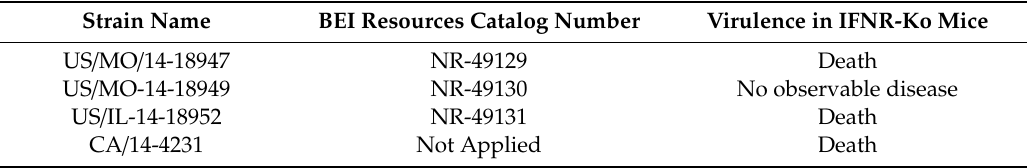
Table 1. EV-D68 strains used in this